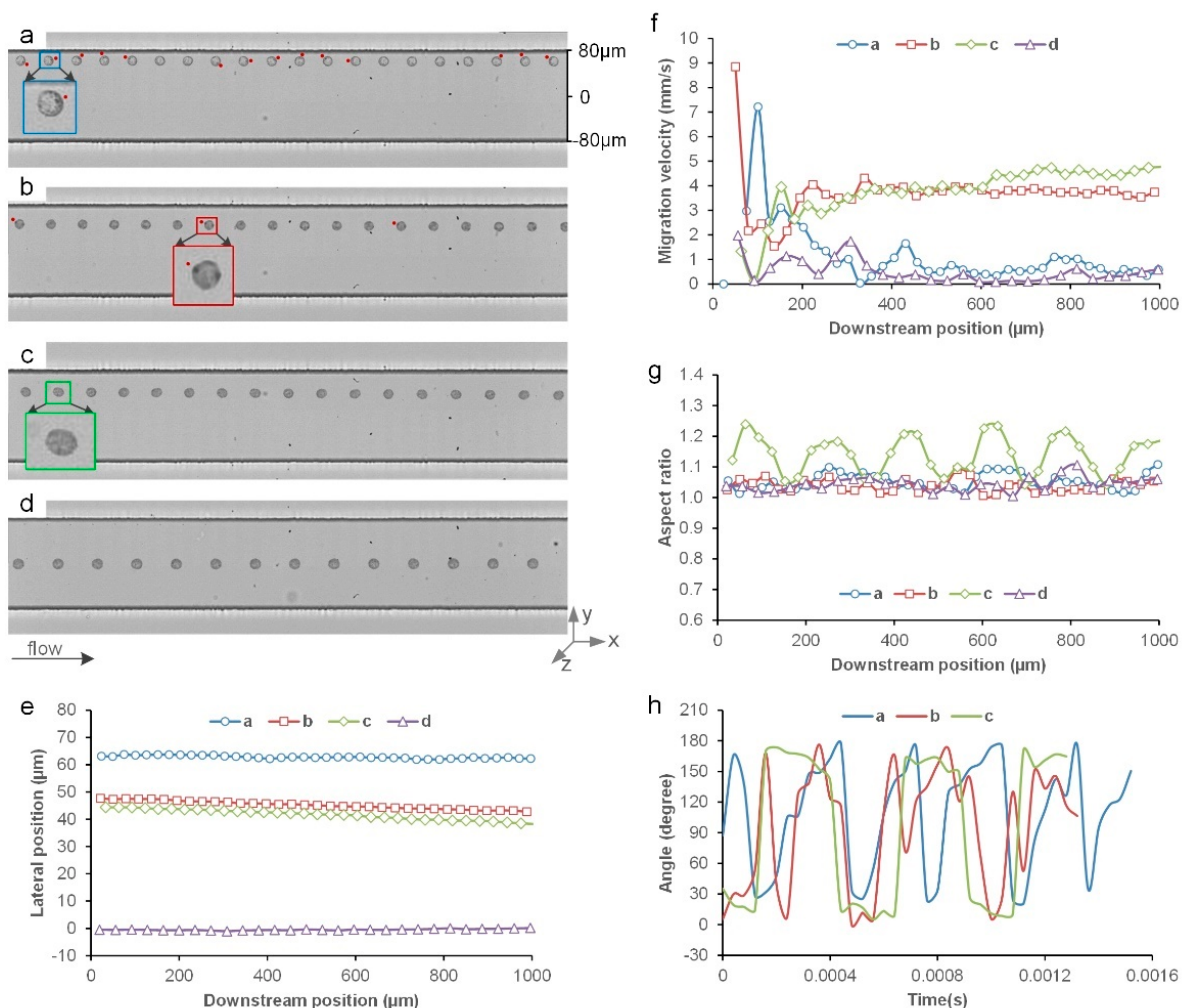
Figure 1. Inertial migration of single cells: ( a ) A single cell near channel sidewall shows very small migration. The red dot indicates the relative position of the dark spot on the cell surface (blowup view in the inset) and shows the rotation of the cell; ( b ) A cell away from the wall migrates toward the channel center. The red dot indicates the rotation of the cell; ( c ) The relatively fast migration of an oval cell; ( d ) A cell close to the channel centerline shows minimal lateral migration; ( e – h ) The lateral displacement, lateral migration velocity, aspect ratio, and the orientation of the single cells shown in ( a – d ). The bright-field images in ( a – d ) are stacked every two frames to show the trajectories of the cells. The angle of the cell in ( d ) was not measured due to the lack of an indicative marker. We found that cells rotate in the flow while traveling downstream. As shown in Figure 1a–c, the dark spots on the cell surface clearly change their position in each frame, indicating cells spinning in the flow. For the cell near the sidewall (Figure 1a), the rotation appears mainly about the z -axis, as the dark spot is visible most of the time in the top view image. The rotation had components about both the y -axis and z -axis for the cells in the middle, as suggested by the periodical disappearance of the dark spot on the cell surface in Figure 1b. The rotation about the two axes is noticeable for the elongated cell in Figure 1c and is reflected in the periodical fluctuation of the cell aspect ratio (AR) curve in Figure 1g. Ideally, the AR curve should not change if the rotation is only about one axis for this ellipsoid cell. Since the cells are not perfectly spherical, as indicated by the AR curves, the rotation about the z -axis can be measured (Figure 1h). The angular velocity around the z -axis was found to be 10,471 rad/s and 12,083 rad/s for the cells in Figure 1a